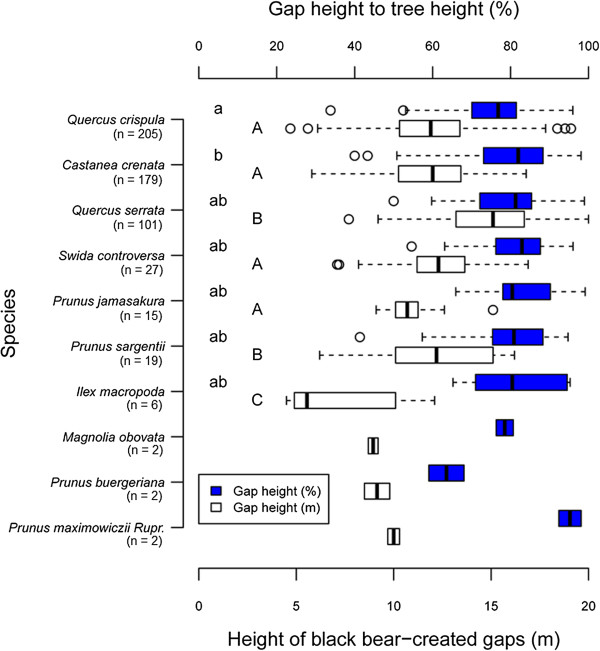
Absolute height of Japanese black bear-created canopy gaps above the forest floor and gap height in relation to tree height (%). Different letters show significant differences among tree species with bear-created canopy gaps (p < 0.05, Bonferroni’s multiple comparison test).